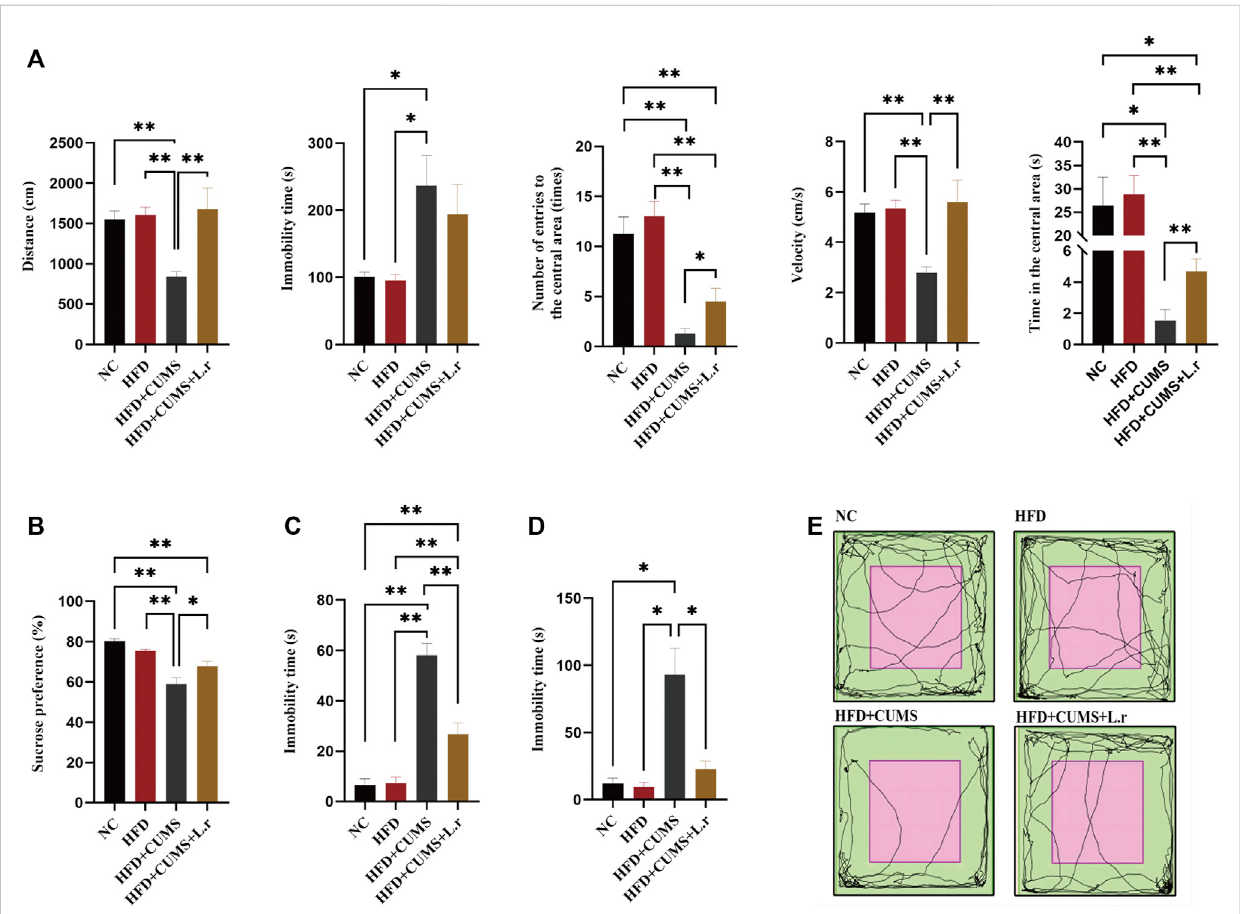
Gavaged with Lactobacillus reuteri attenuated depressive-like behavior ( n = 8 – 9/group). (A) Locomotion activity scores in OFT. (B) Sucrose preference in SPT. (C) Time of immobility in FST. (D) Time of immobility in TST. (E) Activity tracks in OFT. Data are shown as the mean ± SEM. * p < 0.05, ** p < 0.01 (Statistical comparisons between the two groups were performed using the two independent samples t -test. Comparisons between multiple groups were performed using One-way ANOVA and Tukey